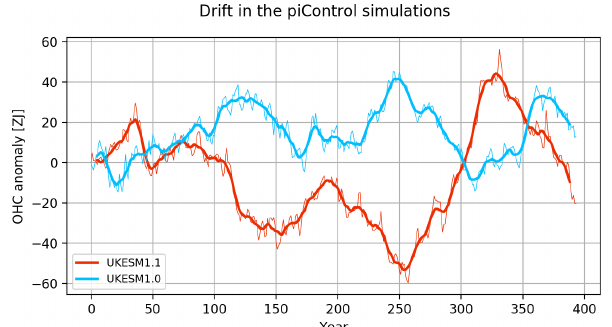
Figure 2. Time series of preindustrial ocean heat content anomalies from UKESM1 (red) and UKESM1.1 (blue). Anomalies are calcu- lated relative to the first year of the piControl simulations and an 11-year running mean, which is plotted as in Fig.